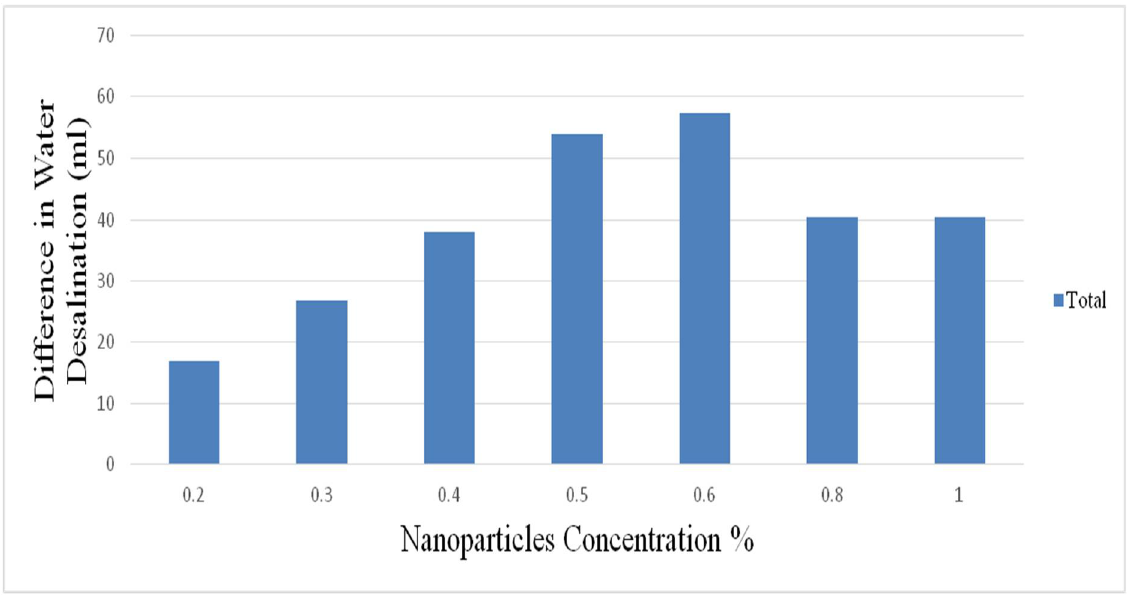
Figure 5. Effect of adding CuO on the condensate.